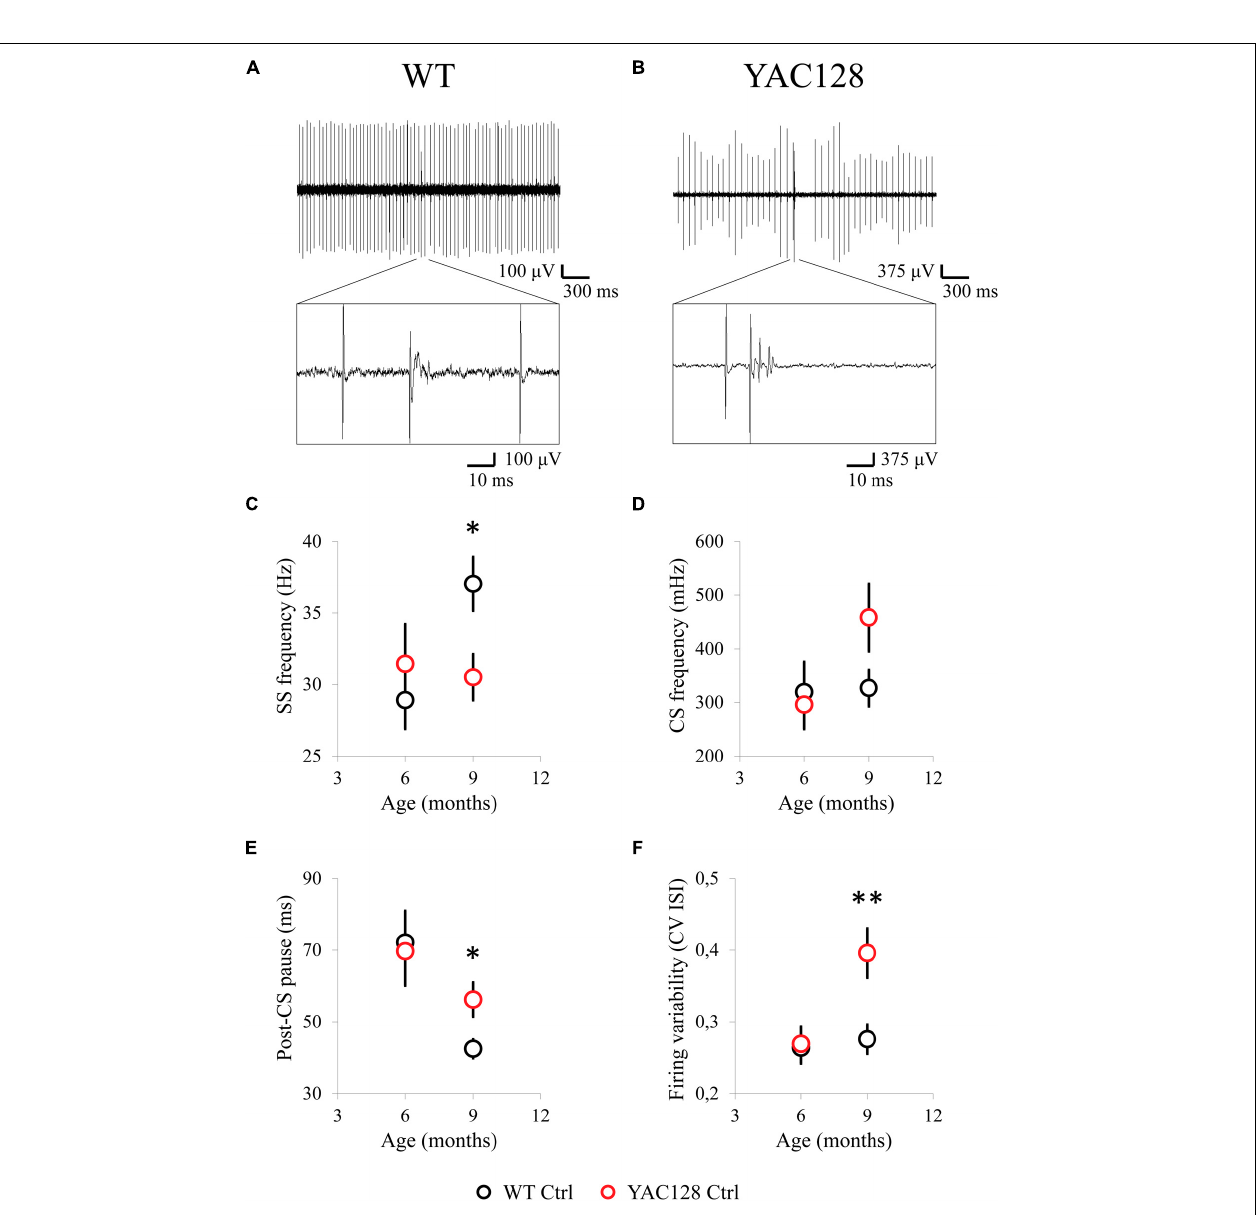
m = 8, ns), for YAC128 Ctrl mice was 3,854 ± 229 ( n = 40, m = 11, ∗ p < 0.05), and for YAC128 CHZ mice was 4,643 ± 313 ( n = 34, m = 9, ns) ( Figure 3B ). Interestingly, while the spikelet frequency was similar between WT and YAC128 control groups, the CHZ treatment led to the significant decrease in the spikelet frequency in YAC128 PCs ( Figure 3C ). Thus, the average spikelet frequency for WT Ctrl mice was 551 ± 15 Hz ( n = 51, m =